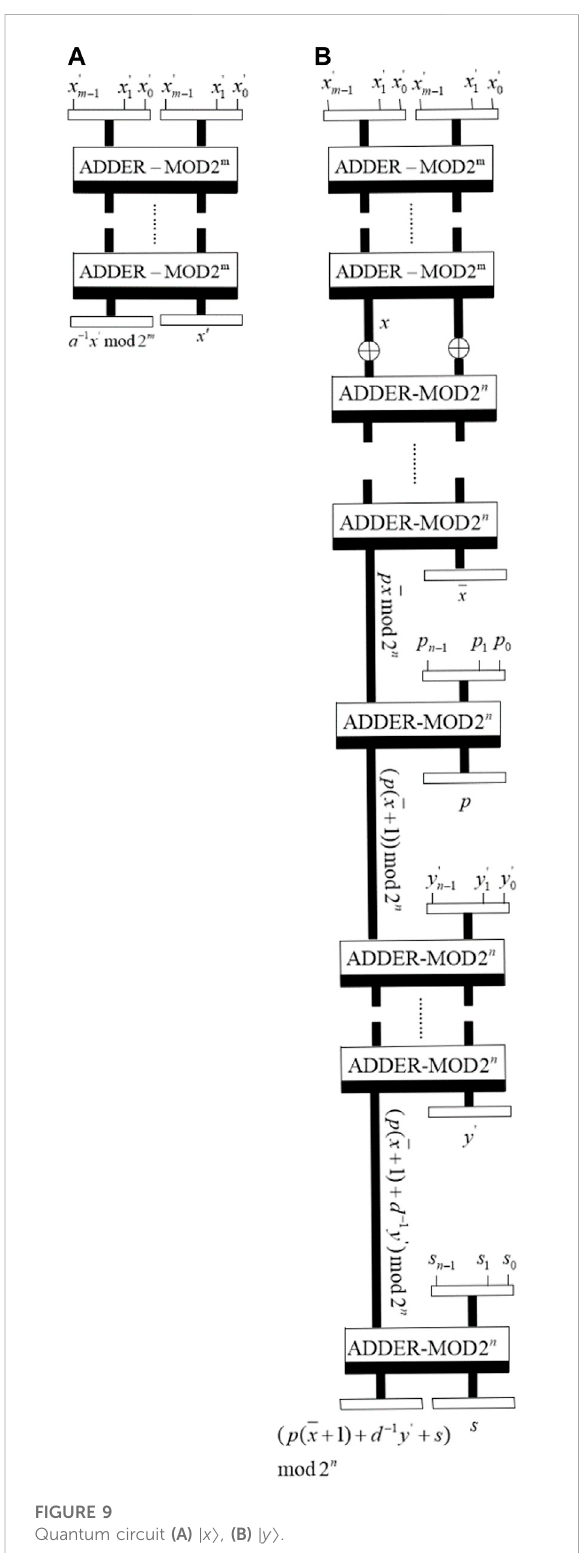
FIGURE 9 Quantum circuit (A) | x 〉 , (B) | y 〉